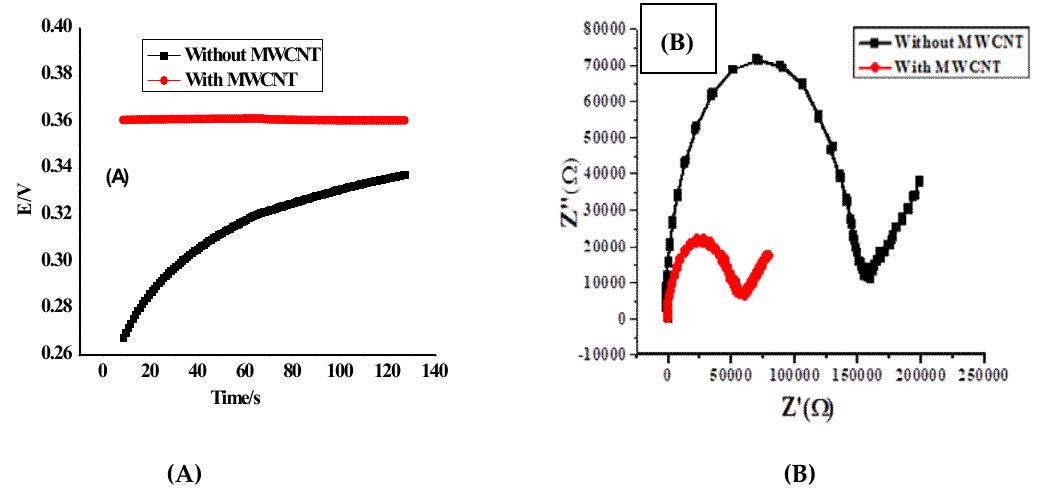
Figure 9. ( A ) Chronopotentiometry and ( B ) impedance plot for FLX / MIP-ISEs, with and without MWCNT as a solid contact material. Abbreviations: ion-selective electrodes (ISEs).